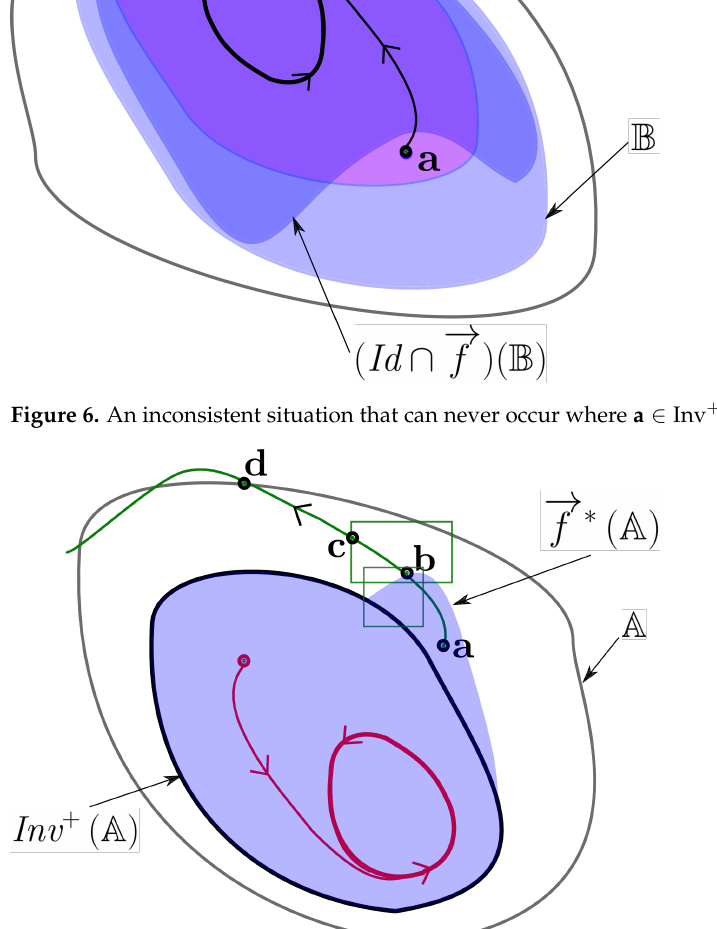
−→ f ∗ ( A ) that is used in the proof of